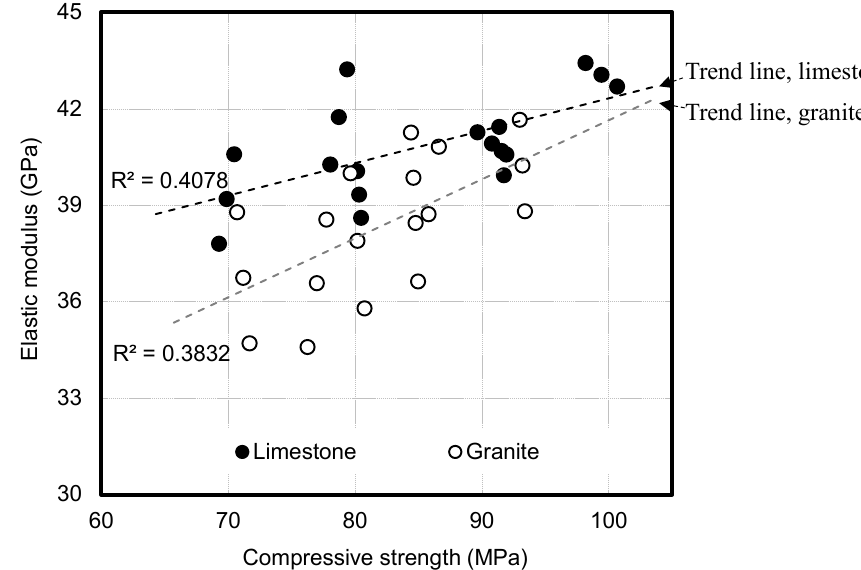
Figure 7. Comparison of compressive strength and elastic modulus of high-strength concrete at 28 and 56 days of age.